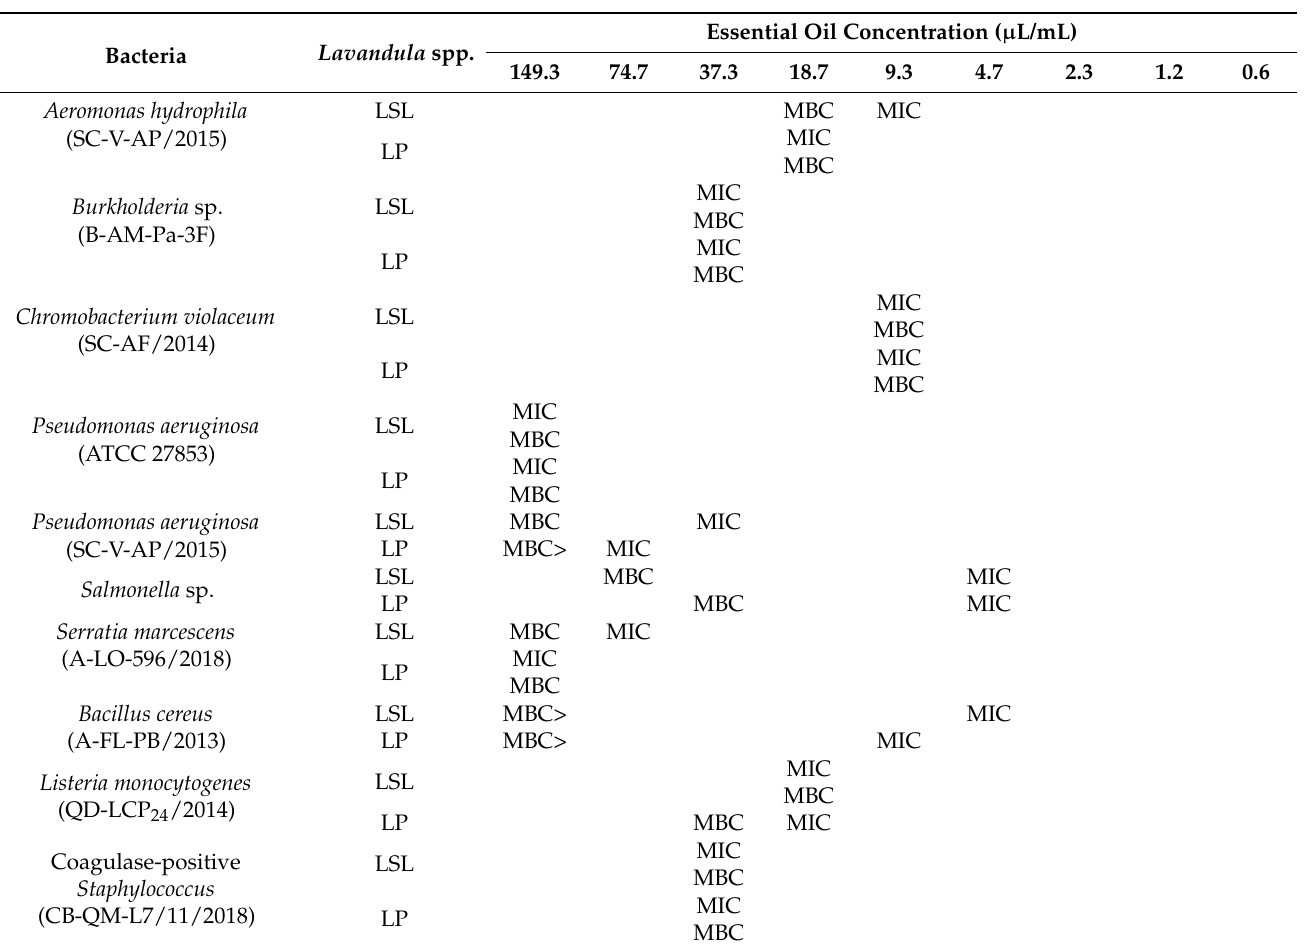
Table 4. Minimum inhibitory concentration (MIC) and minimum bactericidal concentration (MBC) of L. stoechas subsp. luisieri (LSL) and L. pedunculata (LP) essential oils. Lavandula